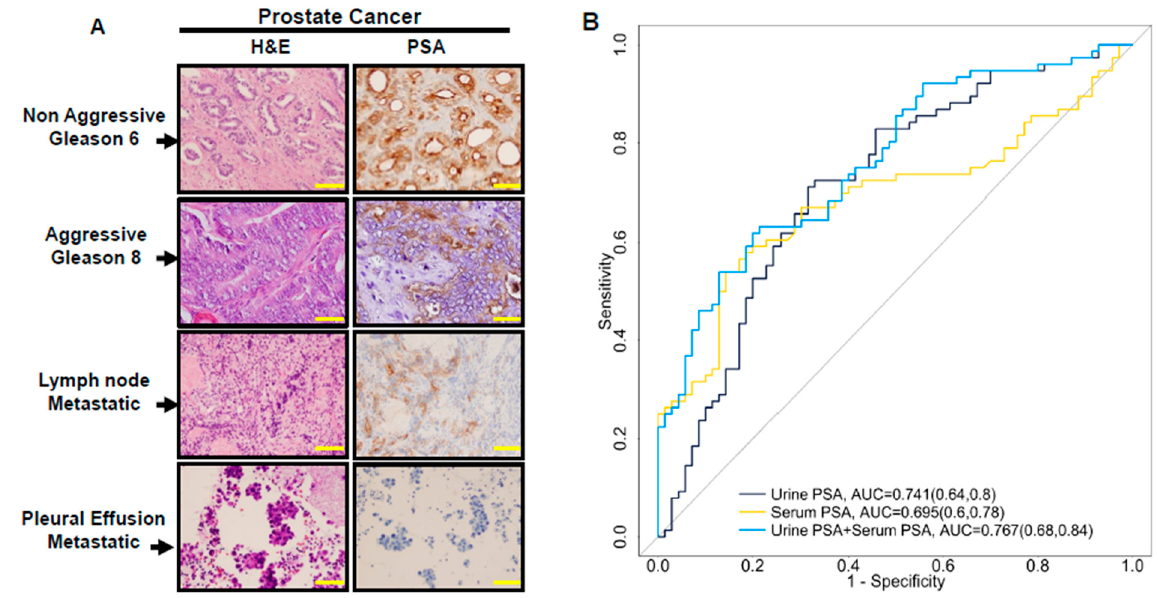
Figure 2. Immuno-histochemistry (IHC) for prostate cancer tissues in aggressive or non-aggressive and metastatic lesions. AUC analysis: the selected 10 × H&E staining and IHC for PSA expression in GS 6 to 8 primary prostate cancer tumors, in lymph node metastasis, and in pleural effusion metastatic tumors were obtained using an inverted light microscope (Zeiss, White Plains, NY, USA). Low staining intensity of PSA expression in aggressive prostate tumors, or loss of expression in some metastatic lesions, were observed ( A ). In ROC analysis, the urinary PSA demonstrated s higher AUC compared to serum PSA in differentiating aggressive from non-aggressive diseases. The combination of serum and urinary PSA further improved the differentiation. A higher ROC curve was obtained when urinary PSA was combined with serum PSA ( B ).